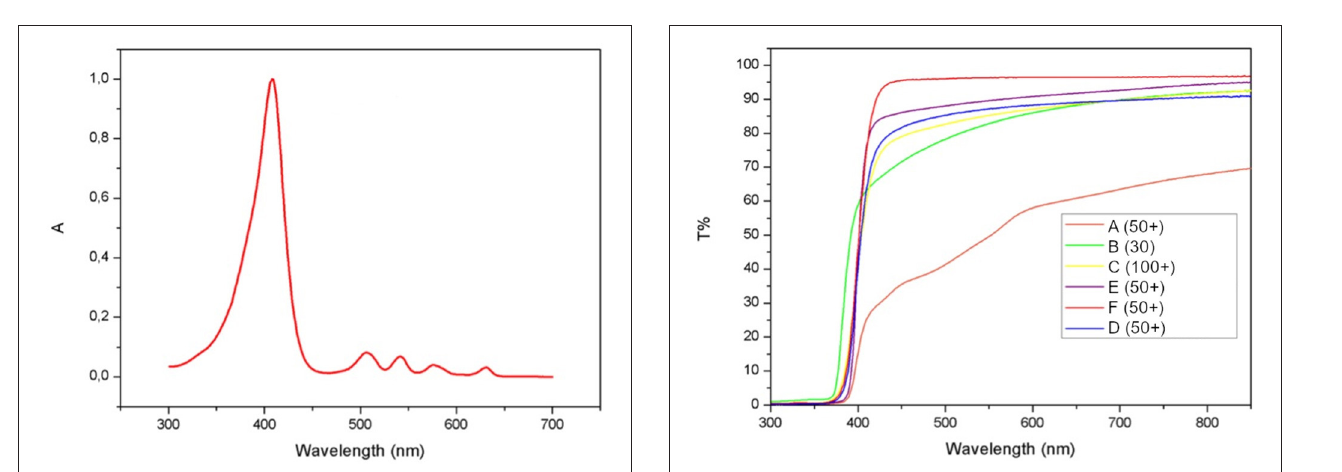
then compared pairwise between products demonstrating a statistically significant difference ( p < 0.05) between medians of product A and each of the five other samples (95% confidence interval): vs. product B (1.68;3.03), vs. C (1.77;2.84), vs. D (1.61;2.94), vs. E (2.00;2.98), vs. F (1.82;3.19).